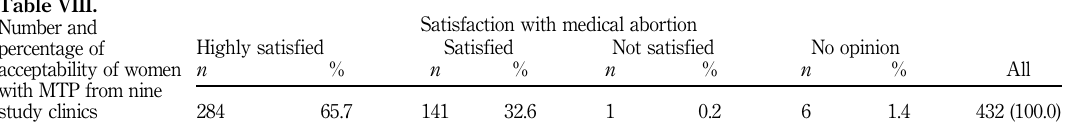
percentage of features of the MTP and bleeding perception of women from nine study clinics